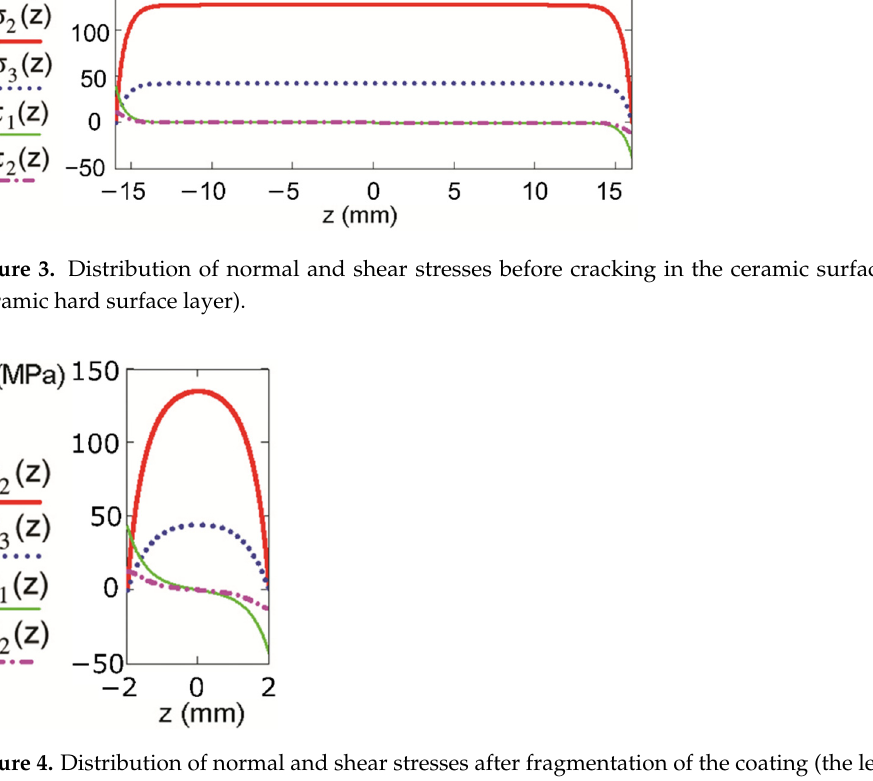
Figure 3. Distribution of normal and shear stresses before cracking in the ceramic surface layer (ceramic hard surface layer).